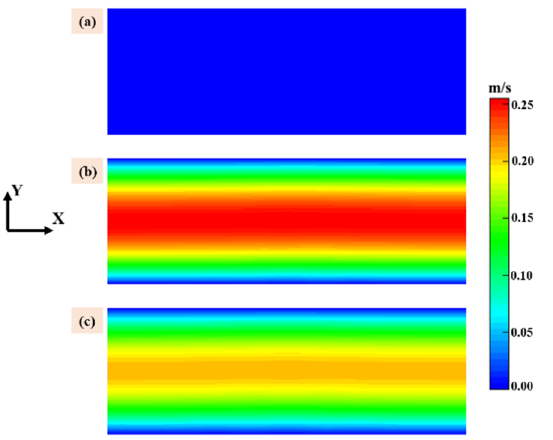
Figure 2. Velocity of the gas phase above the susceptor: ( a ) case 1 and case 2; ( b ) case 3 and case 4; and ( c ) case 5 and case 6.